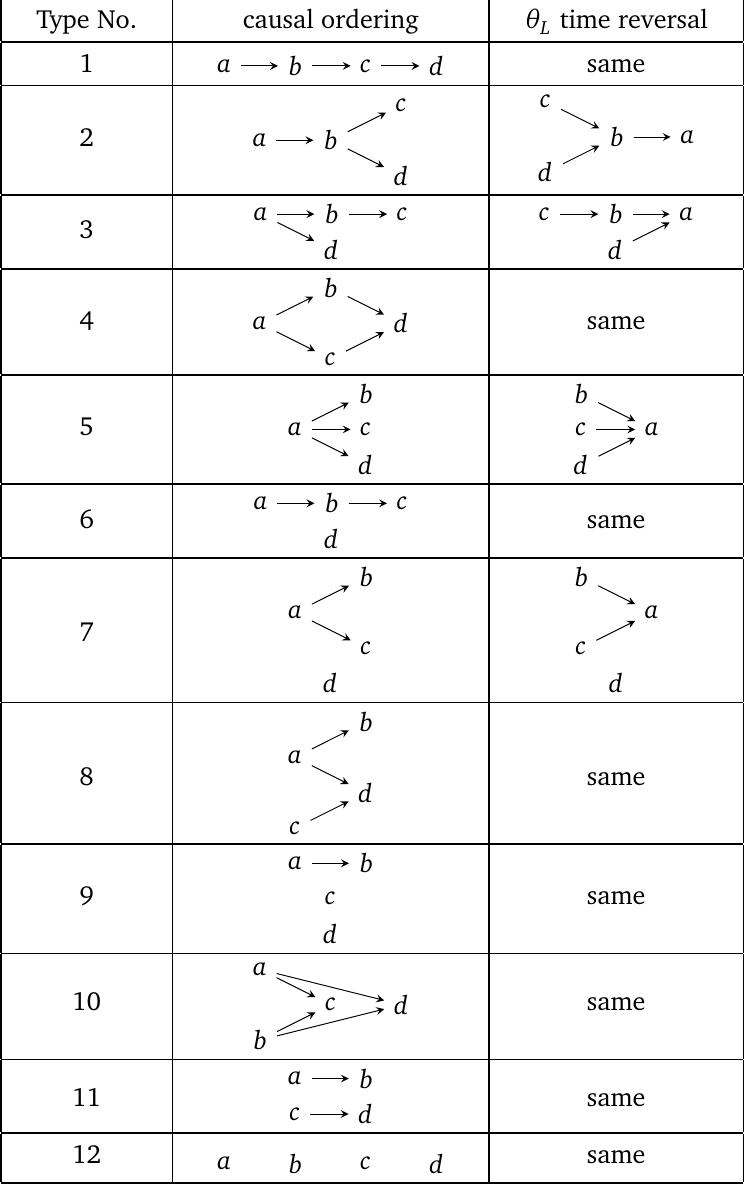
Table 2: Classification of four-point causal orderings Type